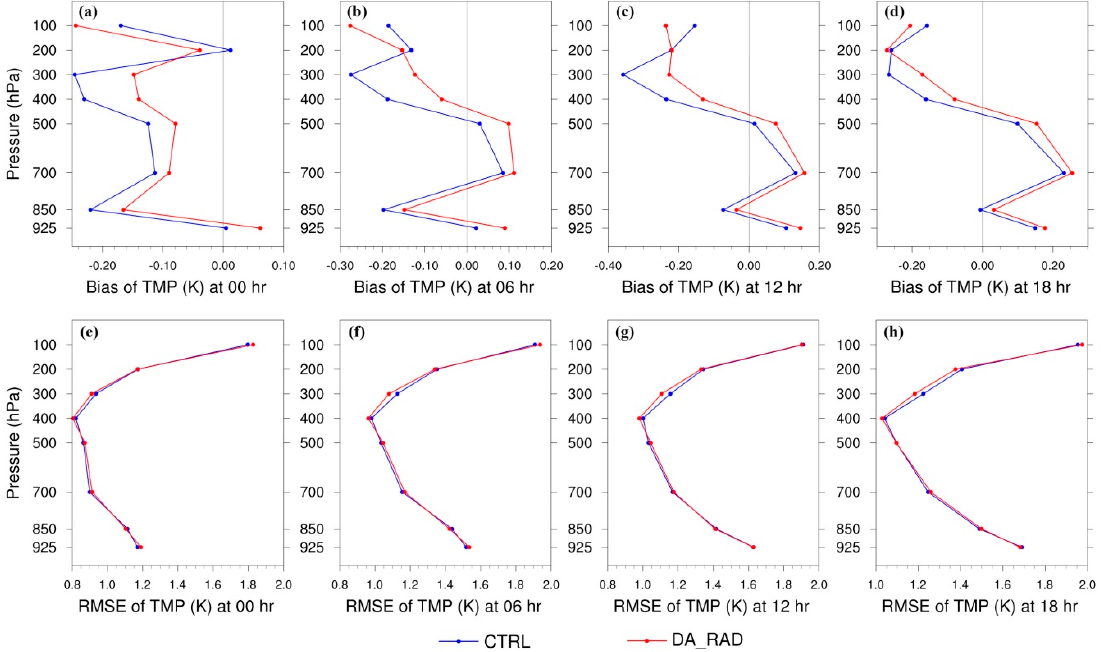
Figure 8. The average bias ( a – d ) and RMSE ( e – h ) of the vertical temperature (TMP) profiles at hours 00, 06, 12, and 18 for retrospective run forecasts (over the period of 1–12 August 2017) without (CTRL) and with (DA_RAD) satellite radiances. Remote Sens. 2019 , 11 , 54